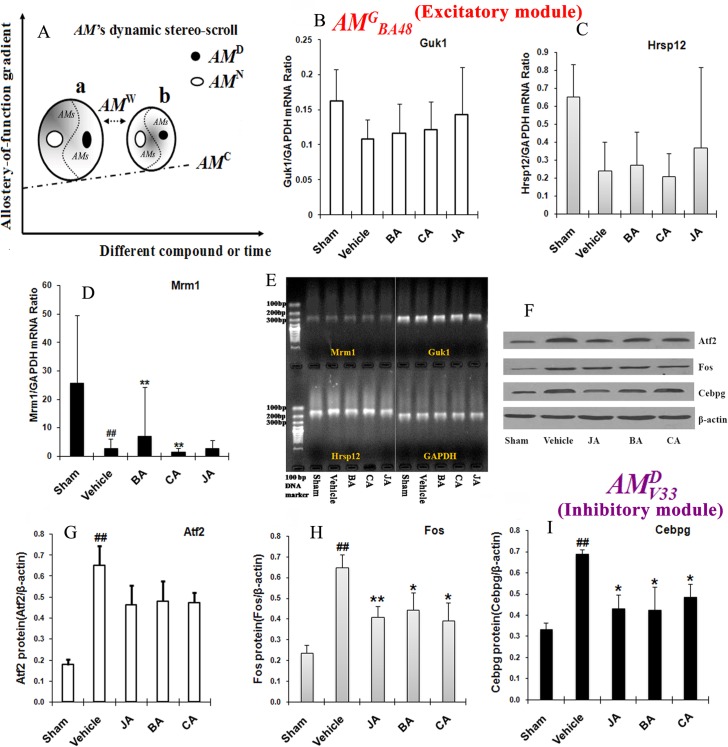
Schematic representation of AM dynamic stereo-scroll and biological verification for AMGBA48 of Mrm1-Guk1-Hrsp12 and AMDV33 of Fos-Cebpg-Atf2.(A) Five types of AMs can structure a multiple-dimensional map in diverse dynamic directions. (B-D) The mRNA levels of Guk1, Hrsp12 and Mrm1 among different treatment groups. #P<0.05, ##P<0.01, compared with the sham group; *P<0.05, **P<0.01, compared with the vehicle group. (E) Representative RT-PCR bands of Guk1, Hrsp12, Mrm1 and GAPDH. (F) Representative immunoblots of Atf2, Fos, Cebpg and β-actin. (G-I) The protein expression levels of Atf2, Fos, and Cebpg among different treatment groups. #P<0.05, ##P<0.01, compared with the sham group; *P<0.05, **P<0.01, compared with the vehicle group.